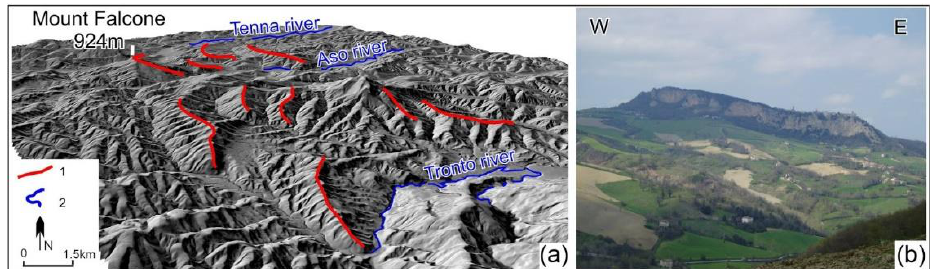
Figure 2. ( a ) 3D digital elevation model of the study sector: 1 — edge of cuesta; 2 — river. ( b ) The arenaceous-conglomeratic body of Mount Falcone.